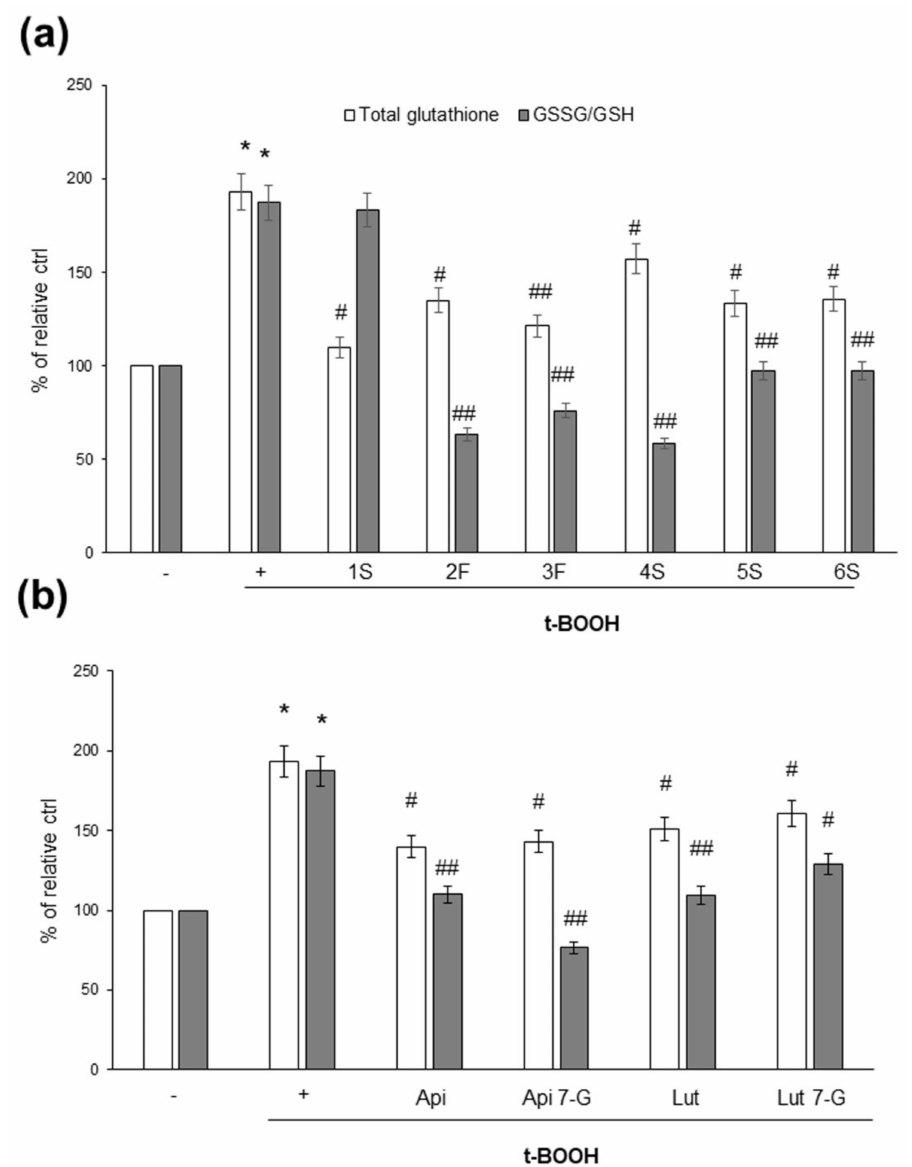
Figure 8. Effects of chamomile extracts and pure flavonoids on intracellular total glutathione content and ratio between the oxidized (GSSG) and reduced (GSH) form. Caco2 cells were grown for 24 h in the absence (+) or in the presence of 100 µ g/mL of each extract ( a ) or 0.5 µ g/mL apigenin (Api), 5 µ g/mL apigenin-7-O-glucoside (Api 7-G), 1.5 µ g/mL luteolin (Lut), or 3 µ g/mL luteolin-7-O-glucoside (Lut 7-G) ( b ). Glutathione content was monitored in cells left untreated ( − ) or treated for 1 h with 2 mM t-BOOH, as described in Materials and Methods. Data are reported as percentage of t-BOOH untreated cells ( − ) arbitrarily set to 100%. Results represent the means ± SEM of 3 independent experiments, each performed in triplicate. * p < 0.0001 vs. t-BOOH untreated cells ( − ) # p < 0.05 and ## p < 0.01 vs. t-BOOH-treated cells